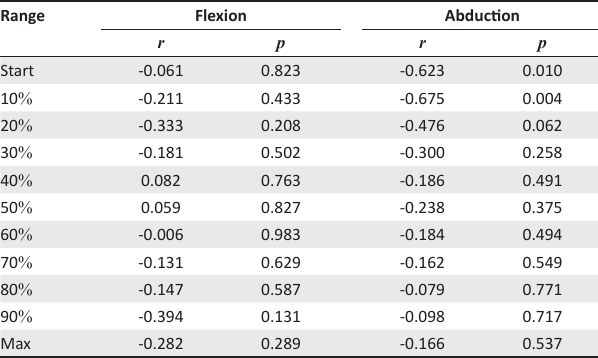
TABLE 3: The correlation between the electromyographic ratios of serratus anterior lower fibres and the lower trapezius in flexion and abduction ( n = 16). Range Flexion